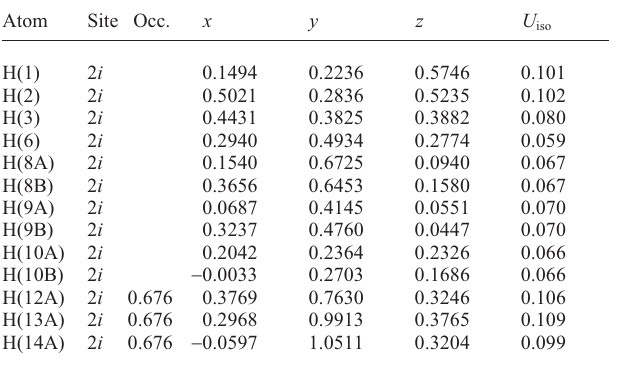
Table 2. Atomic coordinates and displacement parameters (in Å 2 ) .